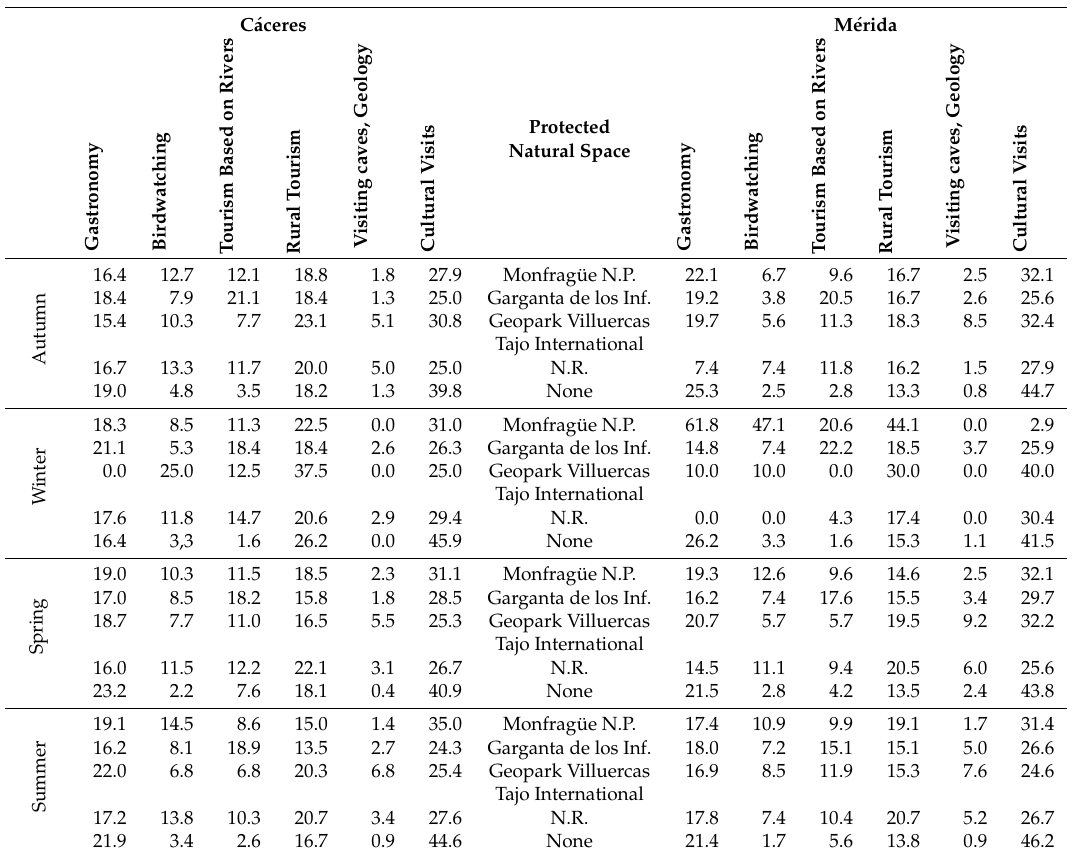
Table 6. Motivations for visiting protected natural